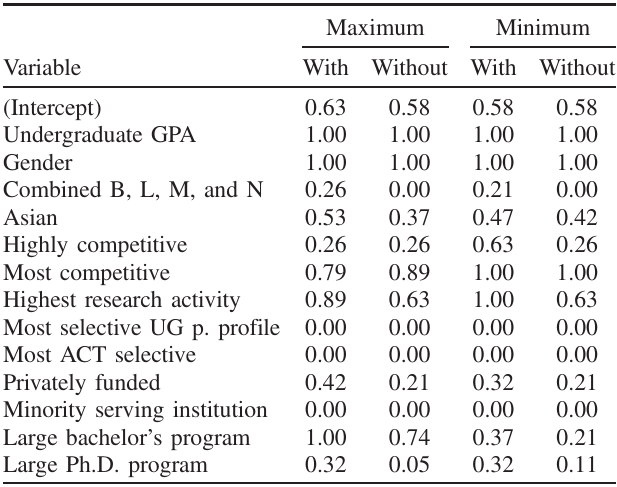
TABLE III. Fraction of P-GRE cutoffs for which the odds ratio of each feature is statistically significant in the logistic regression models. There are 19 logistic regression models in each category (see Sec. III C). The first column (the maximum graduates models with possible duplicates) corresponds to the significance diagram (Fig.